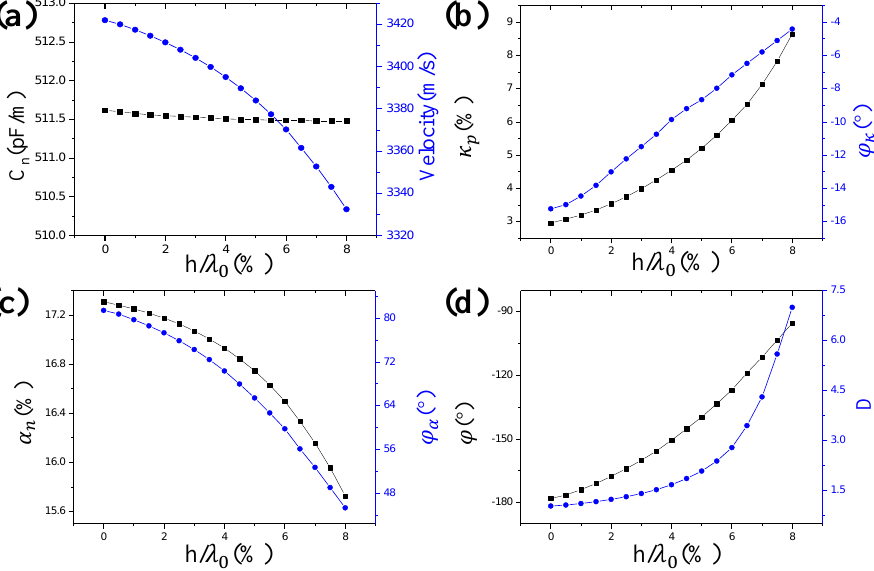
Figure 5. COM parameters versus thickness of electrode for bidirectional IDT on 128°YX LiNbO 3 : ( a ) Normalized capacitance and velocity; ( b ) Reflection coefficient and its phase; ( c ) Normalized transduction coefficient and its phase; ( d ) The unidirectional angle and directivity.